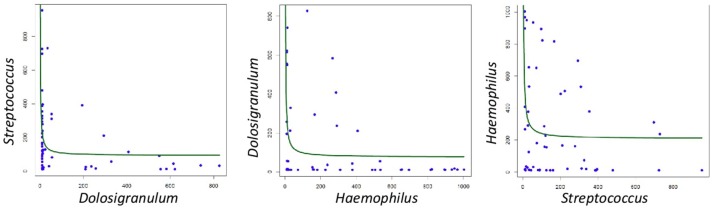
Correlations between the frequency of dominant bacteria in the three nasopharyngeal microbiota types. Data show potential negative associations, as they followed significant hyperbolic regressions.